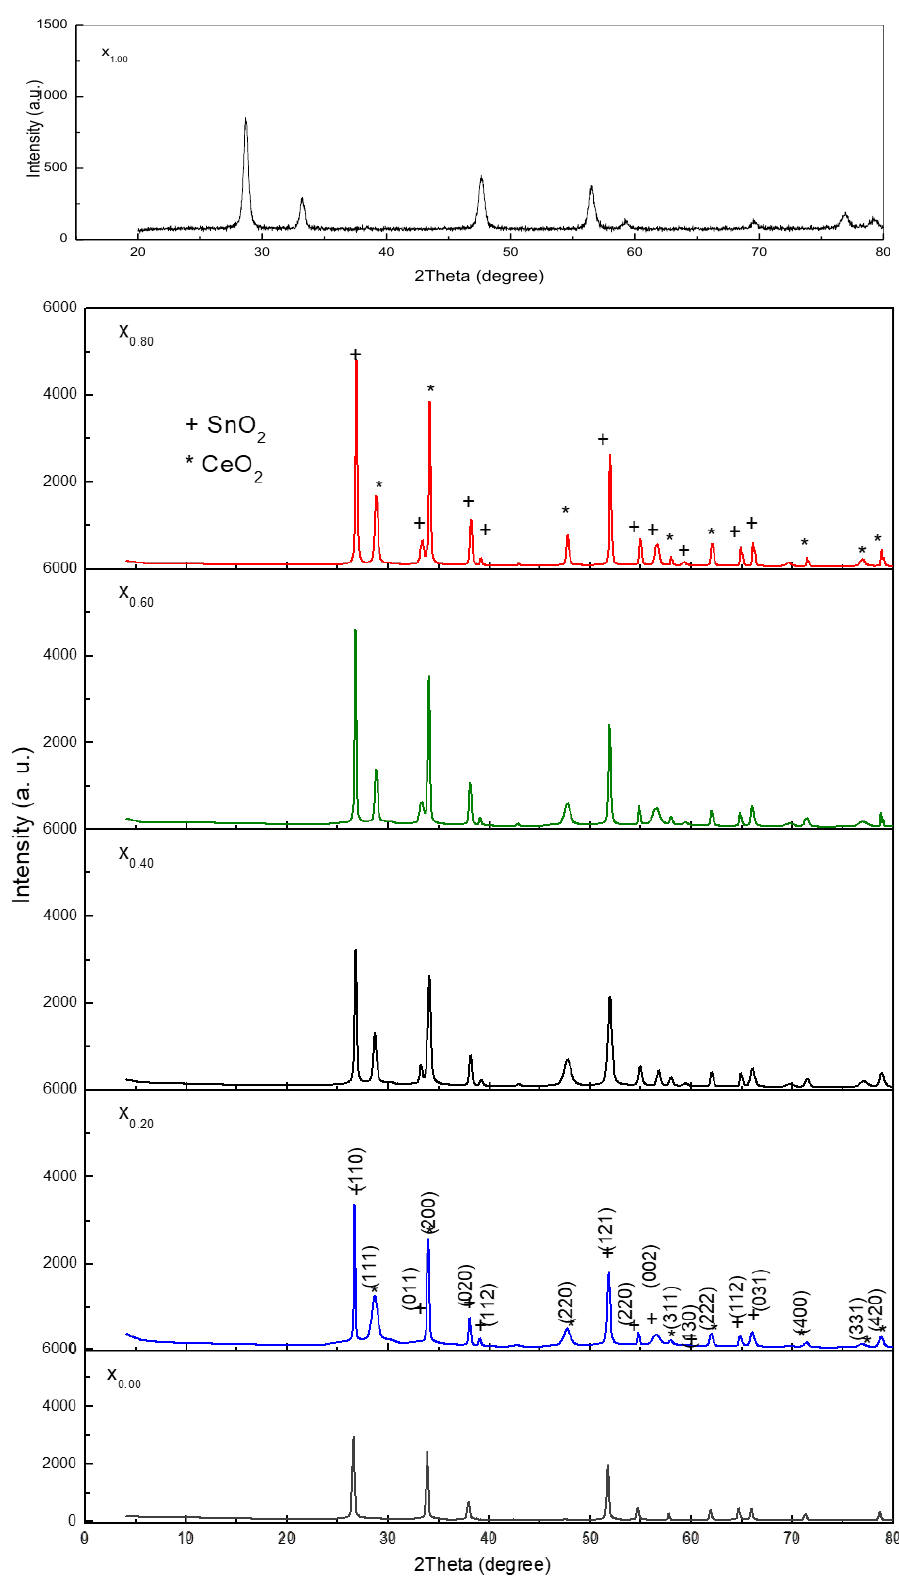
Figure 6. XRD patterns of (x 0.00 ) Ce 0.00 Sn 1.00 O 2 , (x 0.20 ) Ce 0.20 Sn 0.80 O 2 , (x 0.40 ) Ce 0.40 Sn 0.60 O 2 , (x 0.06 ) Ce 0.60 Sn 0.40 O 2 , (x 0.08 ) Ce 0.80 Sn 0.20 O 2 and (x 1.00 ) Ce 1.00 Sn 0.00 O 2 ) nanoparticles calcined at 650 °C. where the X-ray wavelength (1.5406 Å), the full width at half maximum, and the diffrac- tion angle are respectively denoted by λ, β, and θ. Thus, an increase in the x value to 1.00